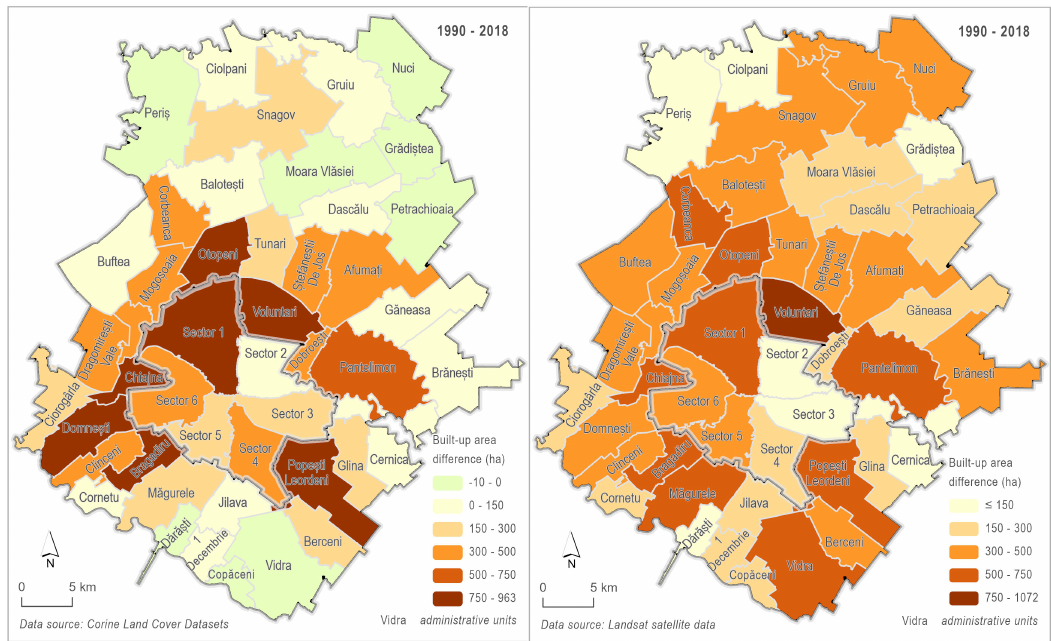
Figure 6. The built-up area di ff erence maps between 1990 and 2018 at the administrative units’ level, based on CLC ( left ) and Landsat classification ( right )